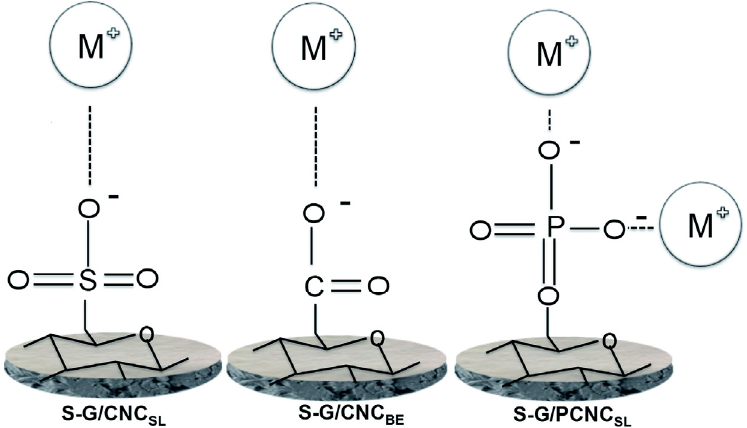
Figure 10. Proposed mechanism for the metal ion adsorption by cellulose nanocomposites investi- gated in [142]. Used under CC BY 3.0.